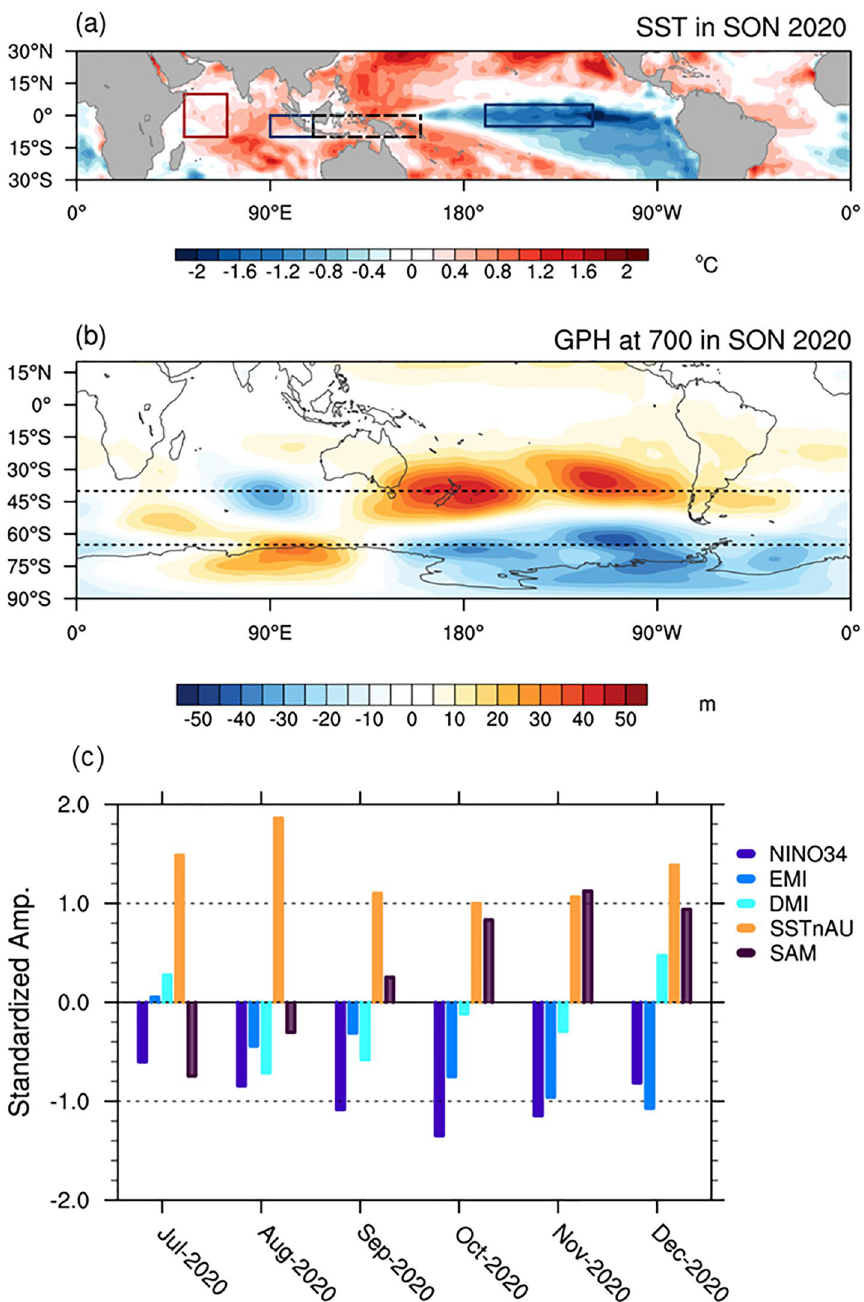
Figure 1. Large-scale conditions of the sea surface and the atmosphere in austral spring 2020. ( a ) September– November mean (SON; i.e., spring) SST anomalies of 2020 relative to 1990–2012 climatology. The red and blue boxed areas are the western pole and the eastern pole of the IOD, respectively; the long-dashed black boxed area is the domain for the SSTs north of Australia considered in this study; and the blue boxed area over the tropical Pacific shows the Niño3.4 region. ( b ) 700-hPa geopotential height anomalies of SON 2020. The short dashed horizontal lines show 40°S and 65°S where nearly zonally symmetric meridional dipole of the SAM is usually found. ( c ) Oceanic and atmospheric climate indices during the second half of 2020. The dark blue, light blue, aqua blue, orange and purple bars indicate the monthly mean values of the Niño3.4 SST, the El Niño Modoki index 33 , the Indian Ocean Dipole mode (IOD) index 3 , the SSTs north of Australia, and the SAM index 9 , respectively. Details of the climate indices shown in ( c ) are described in “Methods”. Maps were generated using the NCAR Command Language version 6.6.2 (www. ncl. ucar.